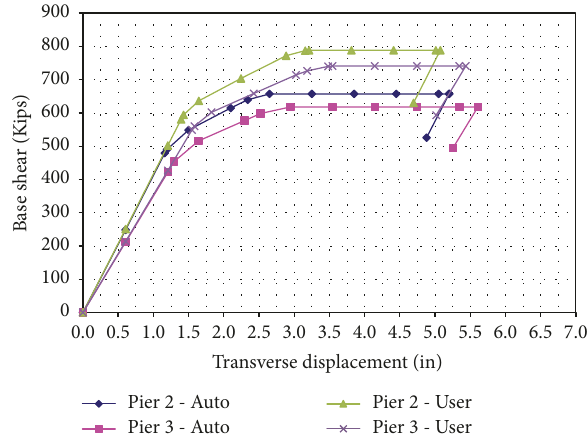
Figure 10: Transverse pushover capacity curve of Bridge #4-W.